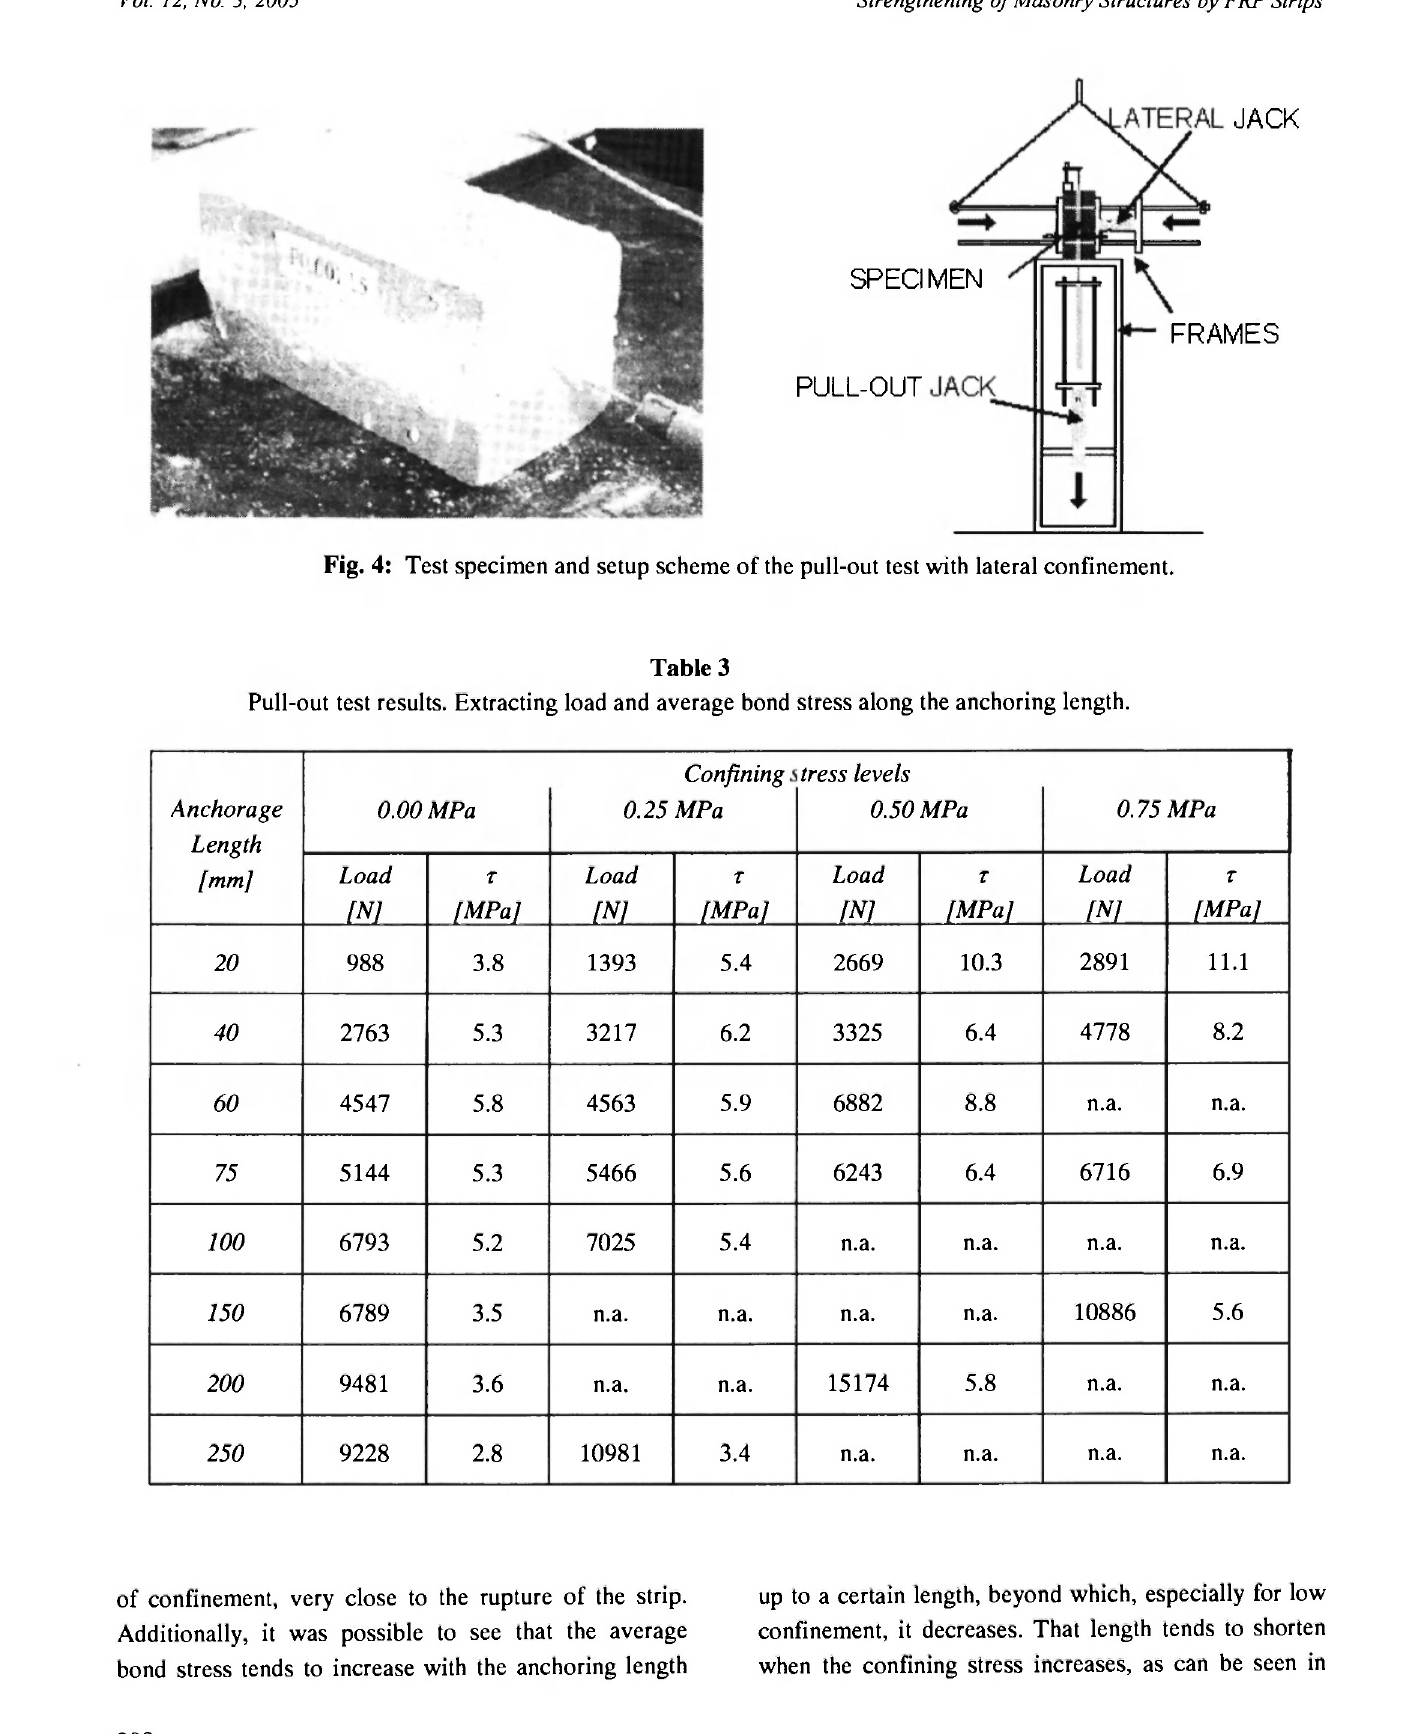
SPECIMEN FRAMES